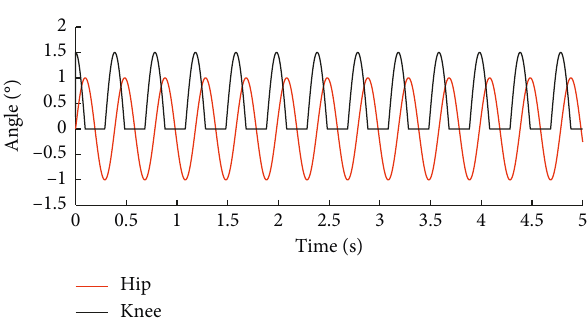
Figure 11: The relationship between the hip and the knee rotation angle in the trot gait.